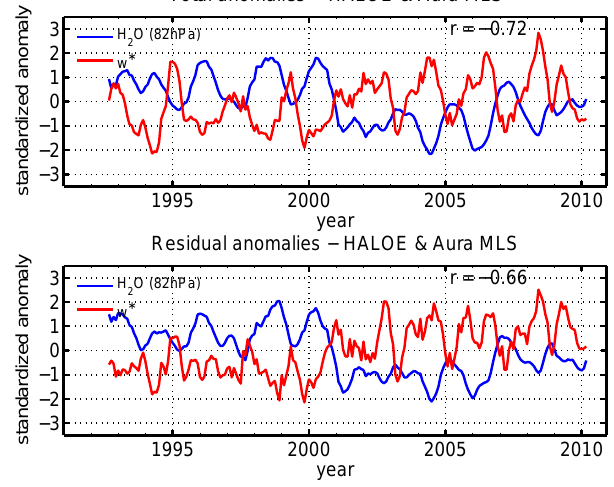
Fig. 13. Time series of mean residual vertical velocity, ⟨ w ∗ ⟩ , in the tropics (22.5 ◦ S–22.5 ◦ N) and the near-global (50 ◦ S–50 ◦ N) water vapour anomalies at 82 hPa . Water vapour data were derived from the HALOE and Aura MLS instruments. Both time series were smoothed by a 5-month running mean and normalized by their respective standard deviations. The time series of the residual vertical velocity leads the water vapour by 3 months. This means that the vertical velocity time series was shifted three months to the left in the plot. The bottom panel show the two anomaly time series after the QBO, ENSO and solar cycle signals have been removed from the original anomaly time series by multilinear regressions.